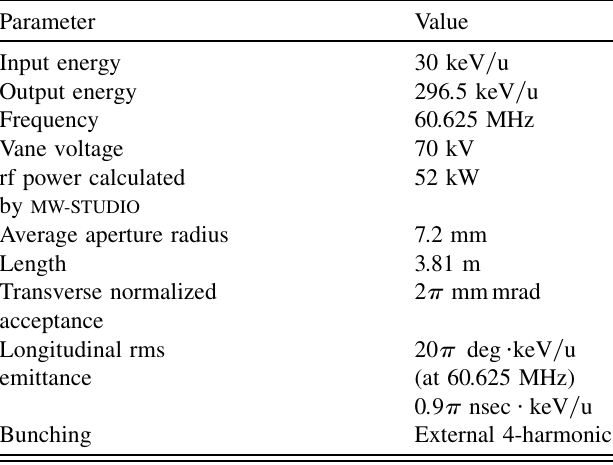
TABLE I. Basic parameters of the